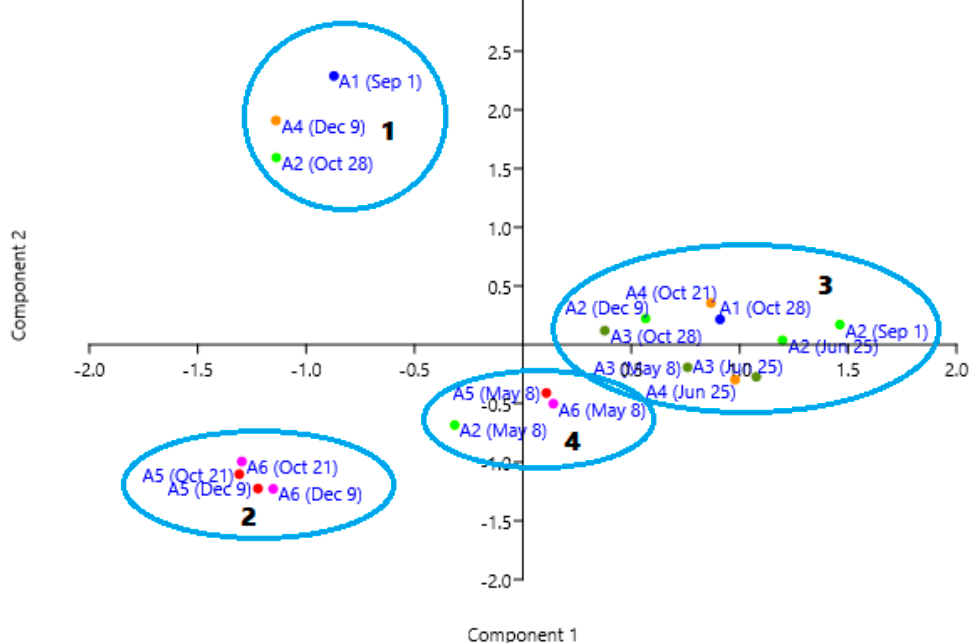
Figure 10. Scatter plot of the sampling points in the space of the principal components 1 and 2. Each sampling point is identified with its location and date according to Figure 1. Groups are labeled according to Figure